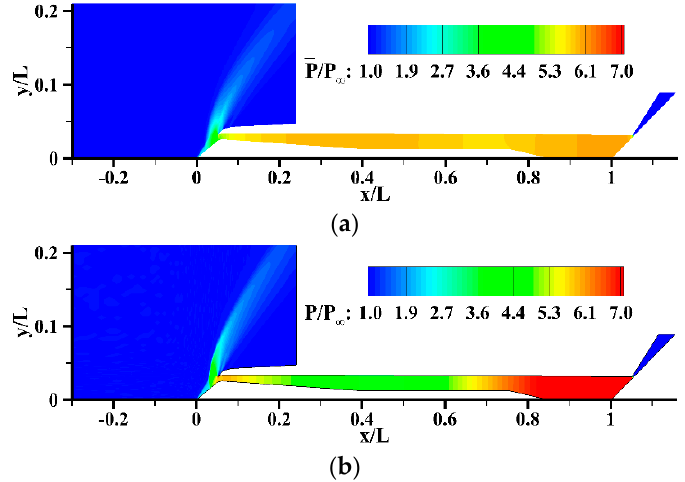
Figure 7. Average and transient pressure distribution from the numerical results: ( a ) Average pressure distribution; ( b ) transient pressure distribution.